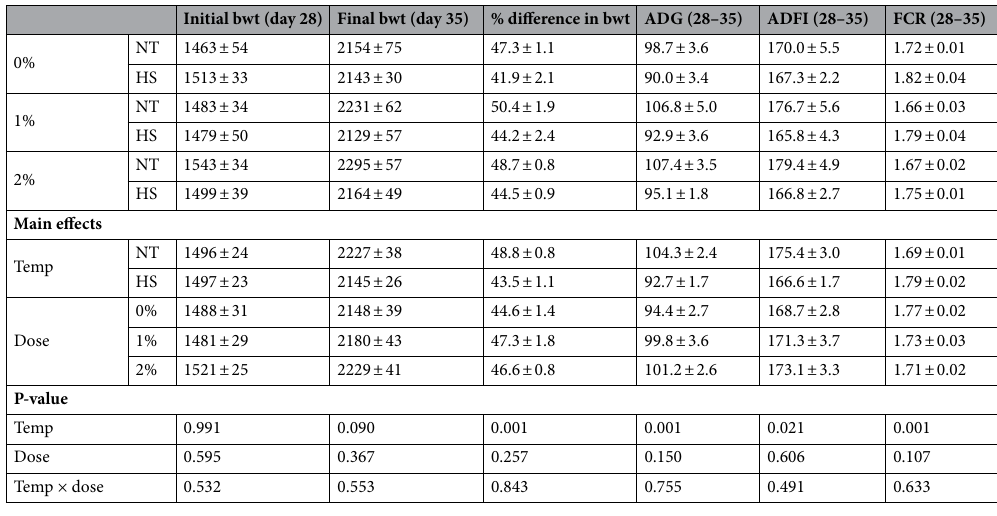
Table 1. Effect of dietary steam-exploded pine particle supplementation on the growth performances of broilers reared under normal or cyclic heat stress conditions. bwt body weight, NT thermoneutral